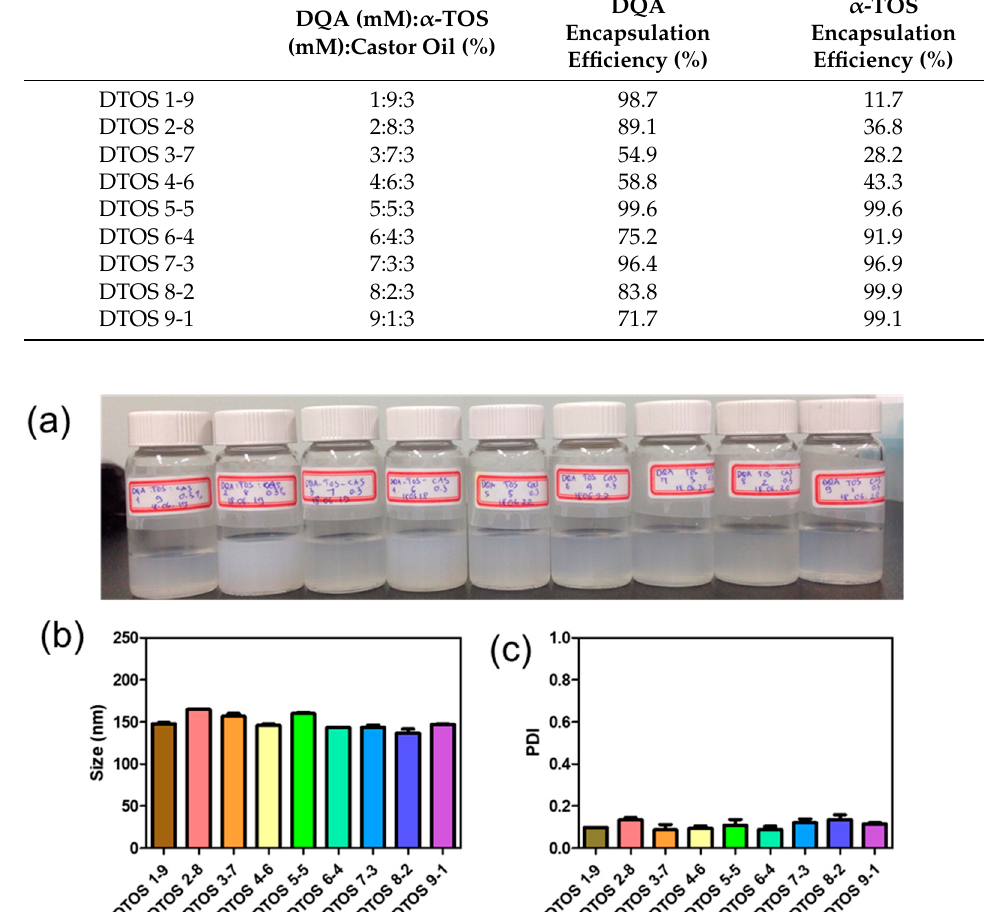
Figure 3. ( a ) Digital photograph of the dequalinium (DQA) and α -tocopherol succinate ( α -TOS) (DTOS) emulsions after preparation. ( b ) Dynamic light scattering (DLS)-measured diameter of the DTOS emulsion after preparation. ( c ) Polydispersity index (PDI) of the DTOS emulsion after preparation. The data are presented as the mean value ± standard deviation of triplicate experiments.